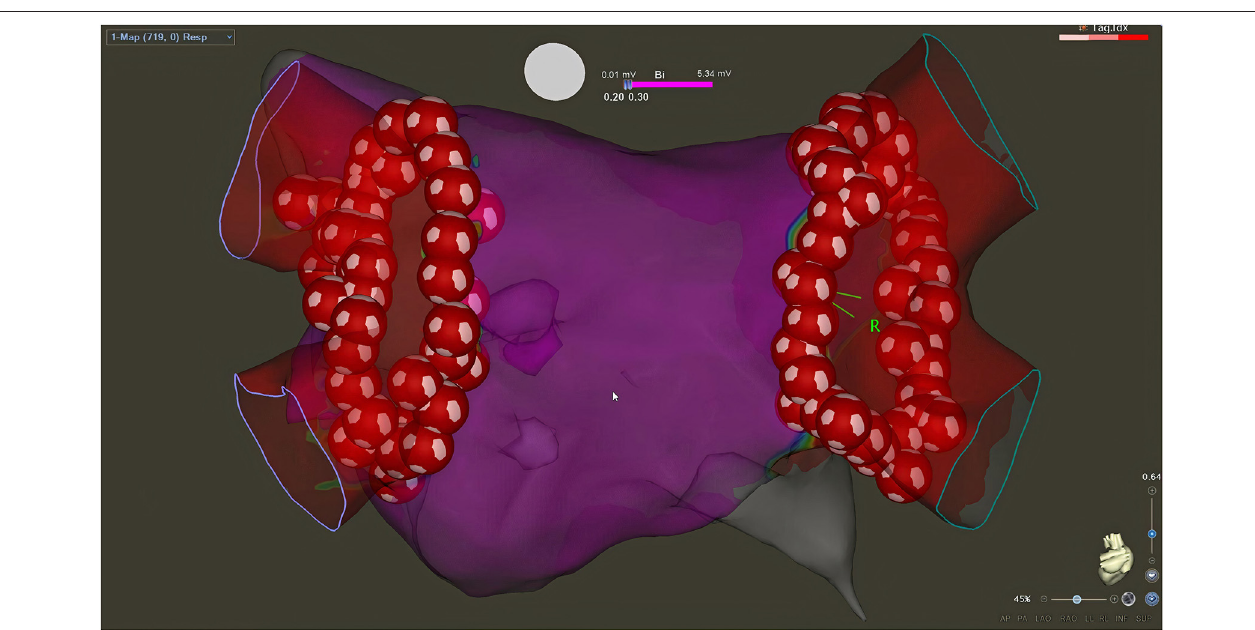
FIGURE 1 | Left atrial voltage map created with CARTO3 electroanatomical mapping system after successful PVI with vHPSD ablation (postero-anterior view). The inter-tag distances are < 5mm between all neighboring points (Heart and Vascular Center, Semmelweis University). absence of disconnection after completing the circumferential ablation, mapping catheter-guided additional vHPSD ablation was delivered until complete isolation was achieved. All